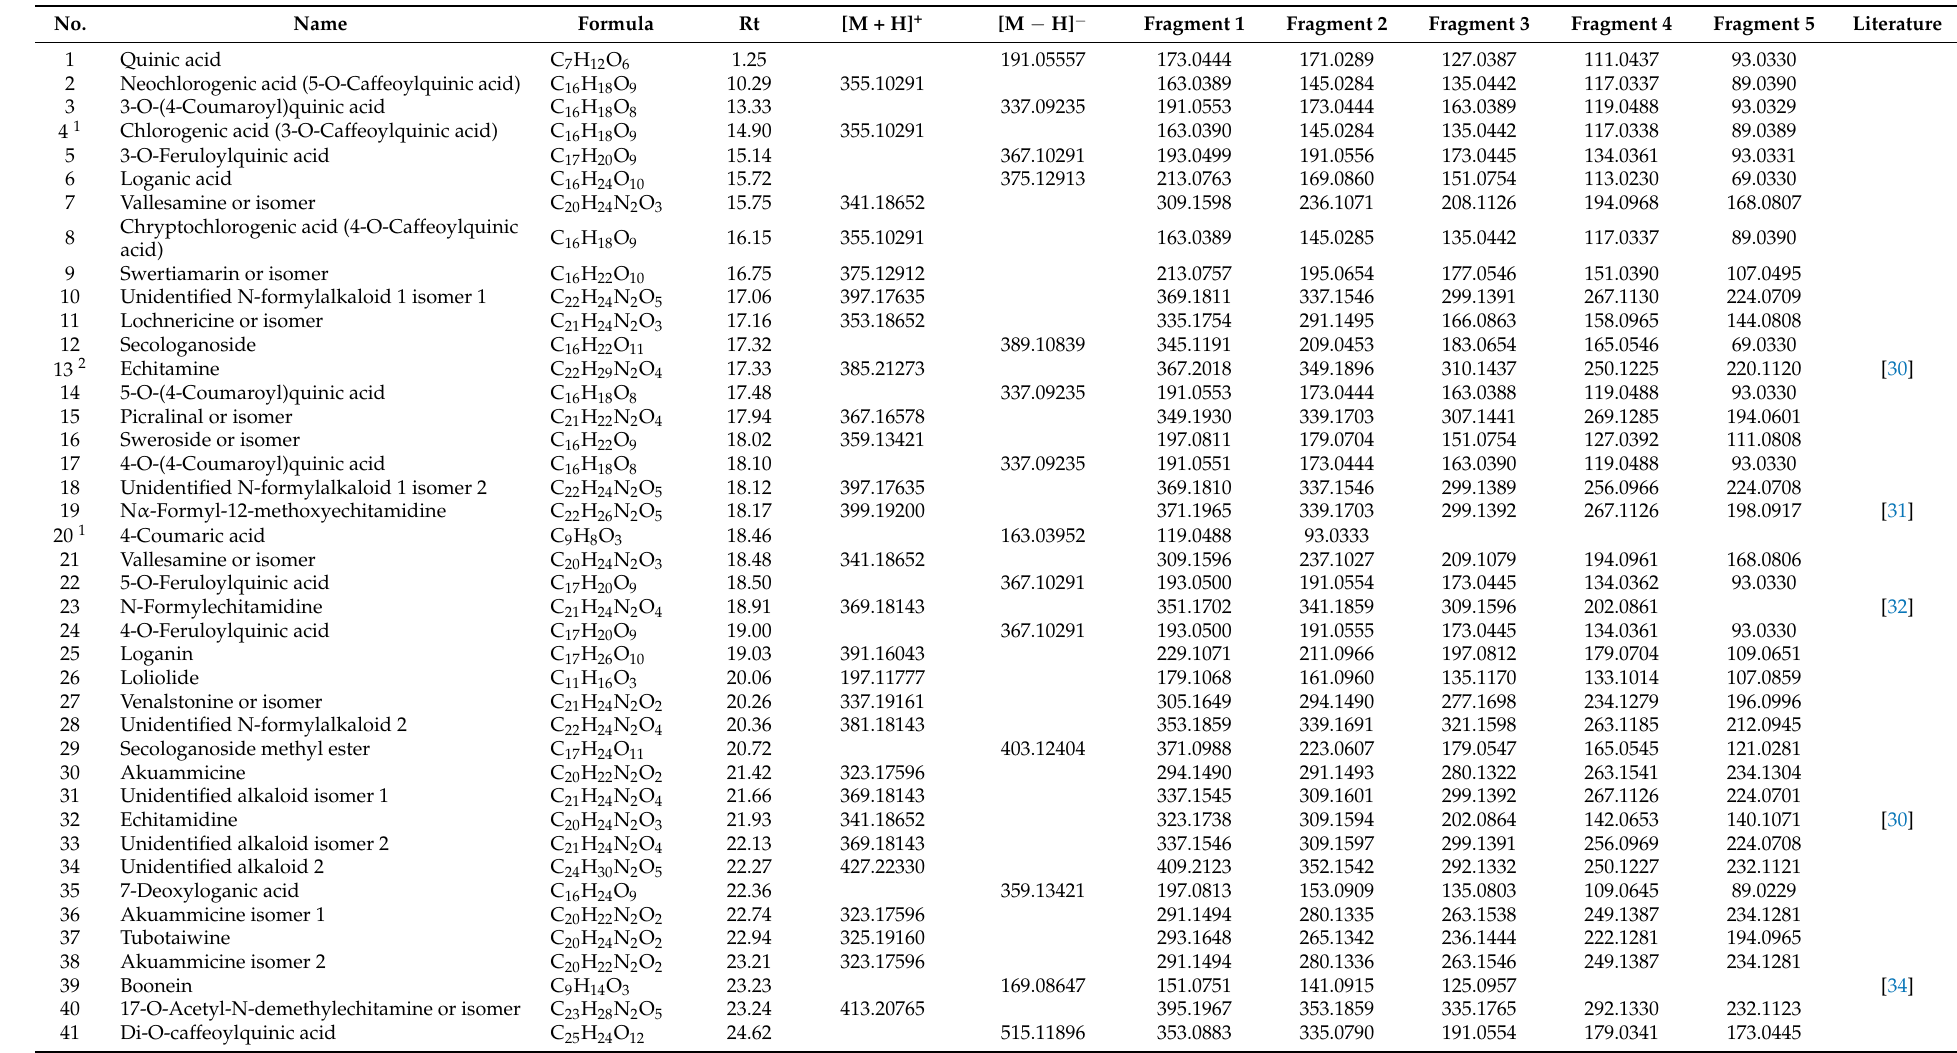
Table 5. Chemical characterization of Stem